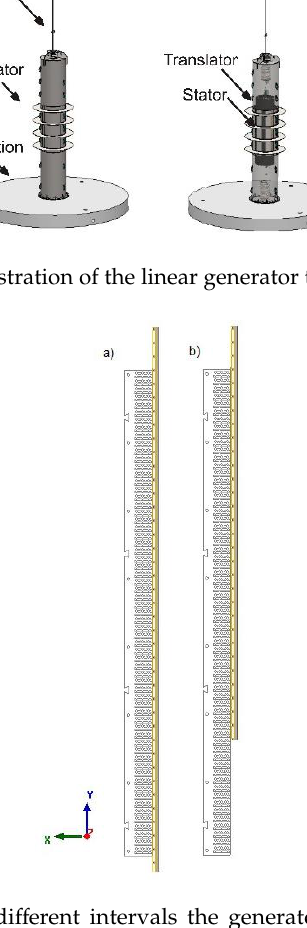
Figure 2. Illustration of the two different intervals the generator is operating in; ( a ) Interval I, ( b ) Interval II. Table 1. The main dimensions of the